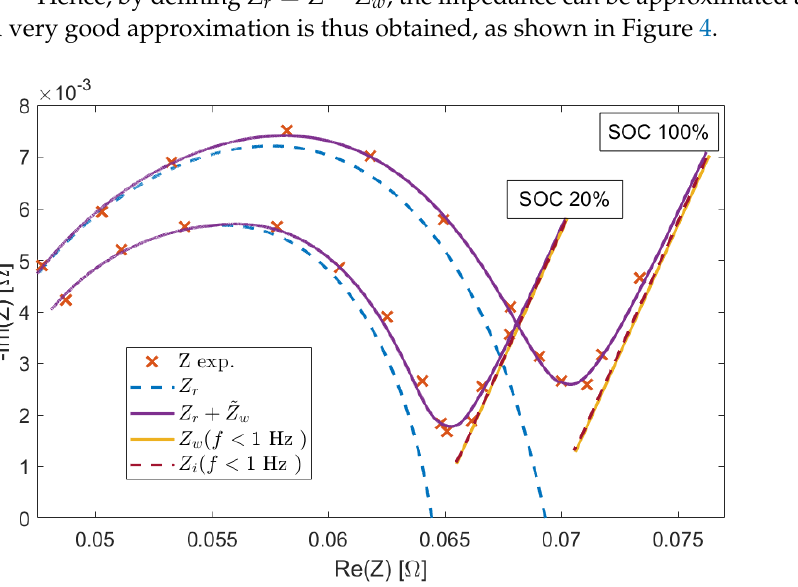
Figure 4. FIR frequency response obtained by using the approximation (7) compared with the experimental data. The components Z r , Z w and Z i are also reported as to show the goodness of the approximation Z w ≈ Z i for f < 1